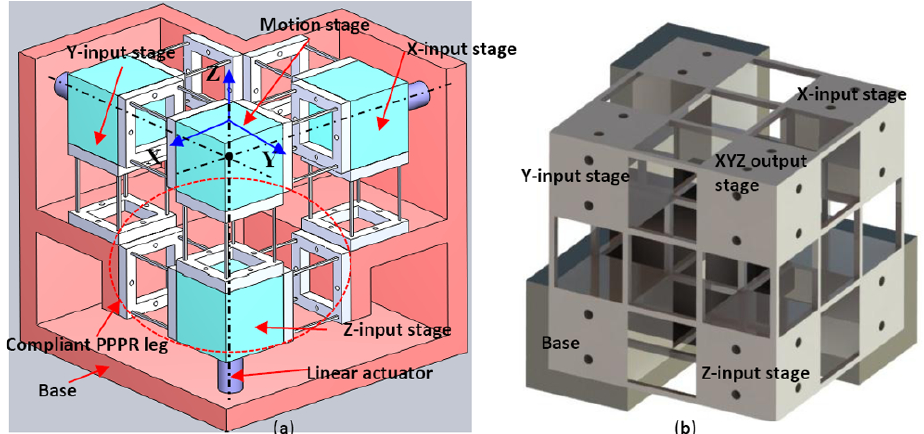
Figure 2. A compact and decoupled XYZ compliant parallel manipulator composed of identical spatial four-beam modules: (a) 3-PPPR XYZ CPM, and (b) corresponding monolithic design to be fabricated from a cubic material by three orthogonal directions’ cutting.